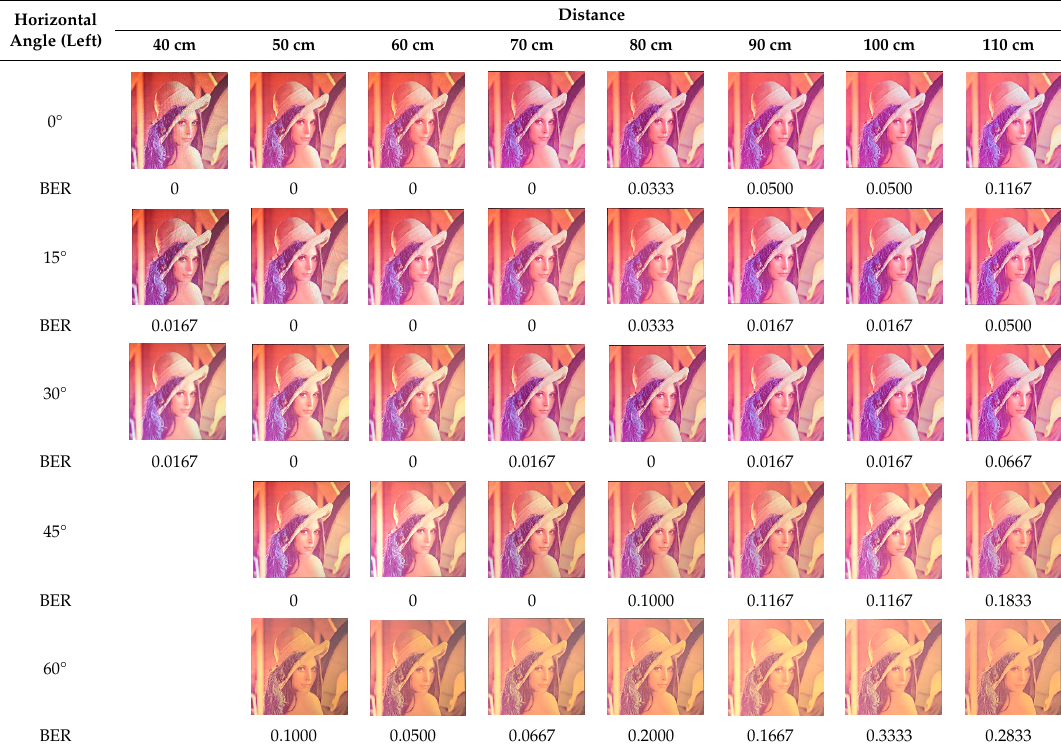
Table 4. Examples of Lena recovered from different captured images.